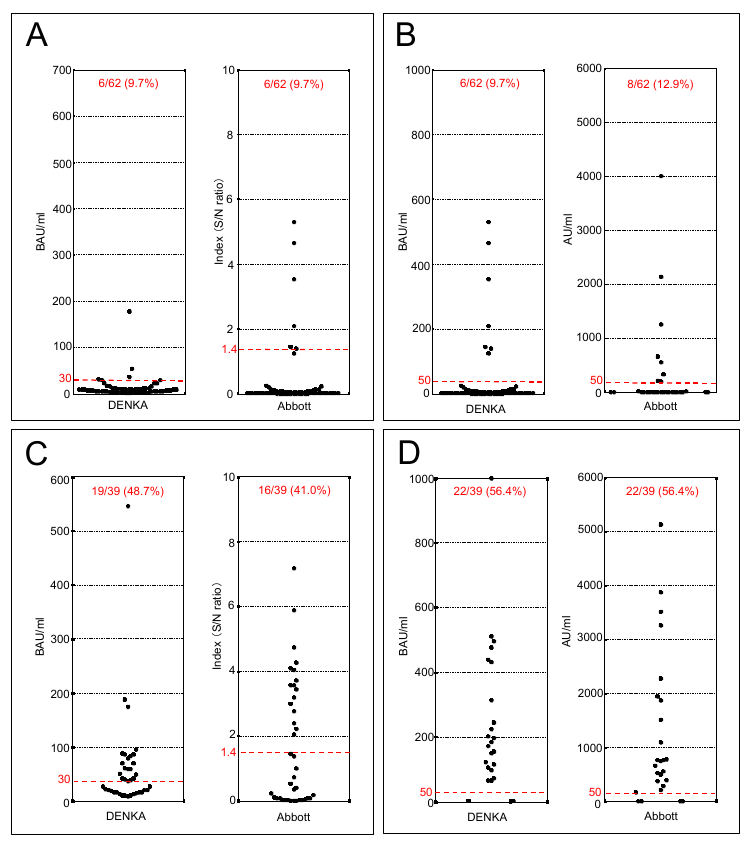
Figure 2. IgG antibody responses of SARS-CoV-2 in nursing care home in Niigata, Japan, April 2021 ( n = 101). ( A ) Responses of severe acute respiratory syndrome 2 (SARS-CoV-2) in staff’s anti-nucle- ocapsid (N) IgG antibodies by DENKA (Tokyo, Japan) and Abbott (Illinois, USA). ( B ) Responses of SARS-CoV-2 in staff’s anti-spike (S) IgG antibodies by DENKA and Abbott. ( C ) Responses of SARS- CoV-2 in resident’s anti-N IgG antibodies by DENKA and Abbott. ( D ) Responses of SARS-CoV-2 in resident’s anti-S IgG antibodies by DENKA and Abbott. The percentage of positive cases (%) is de- scribed and the red dotted line indicates the threshold for positivity (i.e., positive cutoff index).